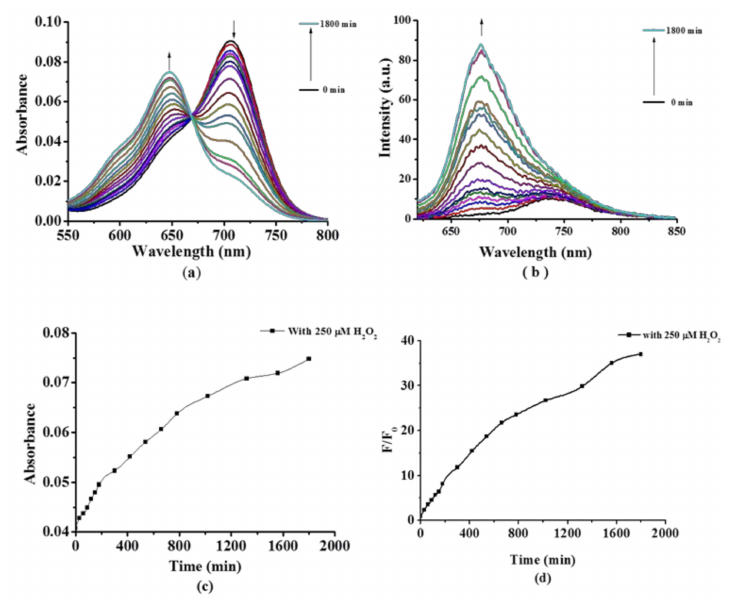
Figure 5. ( a ) Absorption and ( b ) fluorescence emission spectra for compound 7 (1 µ M) upon incubating with H 2 O 2 (250 µ M) for varying time intervals; the plots show the time-dependent increases ( c ) absorption at 647 nm and ( d ) fluorescence intensities at 678 nm; the experiments are carried out in phosphate buffer solution (10 mM, pH 7.4) containing 0.05% Tween 8.